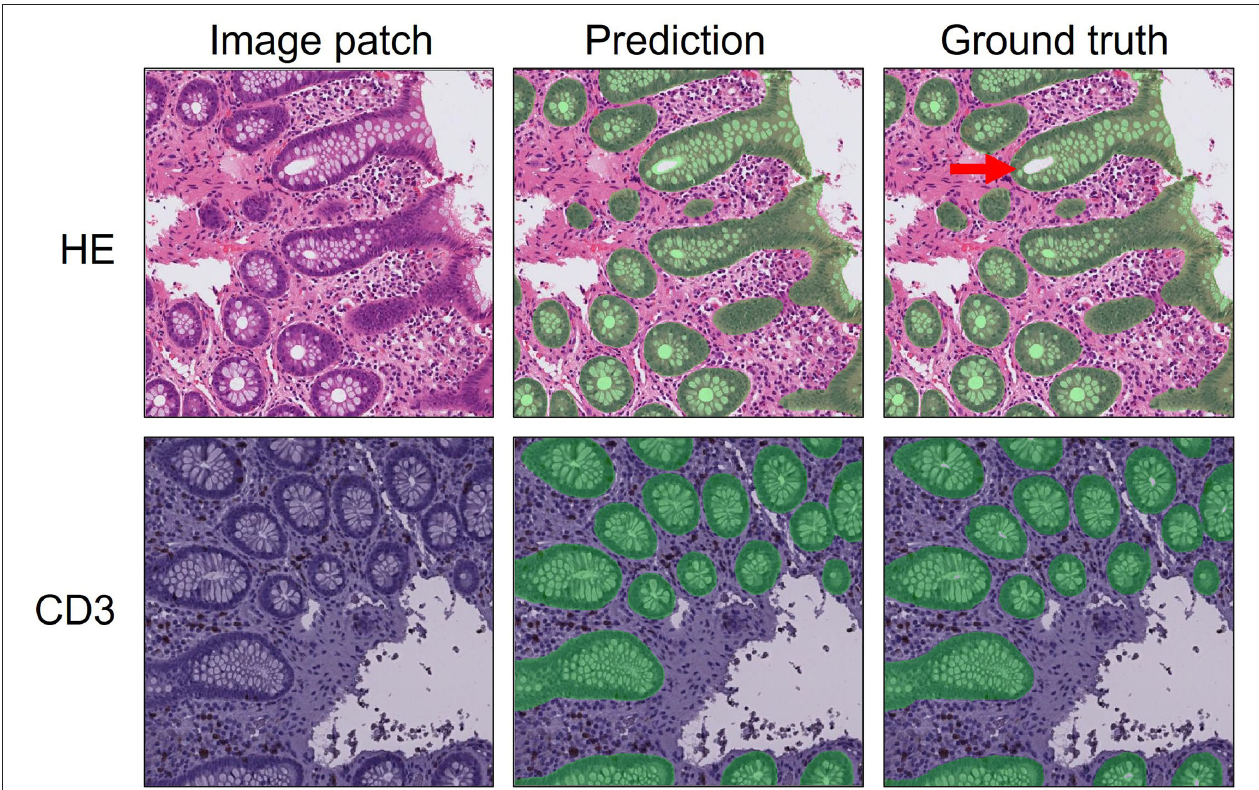
FIGURE 2 | Examples of predictions (middle column) and ground truth (right column) of epithelial segmentation (transparent green) of HE stained (top row) and CD3 immunostained (bottom row) 512 × 512-pixel image patches in DeepMIB. The arrow shows the approximate cut-offs for (filled or unfilled) minimal tubule hole size used during